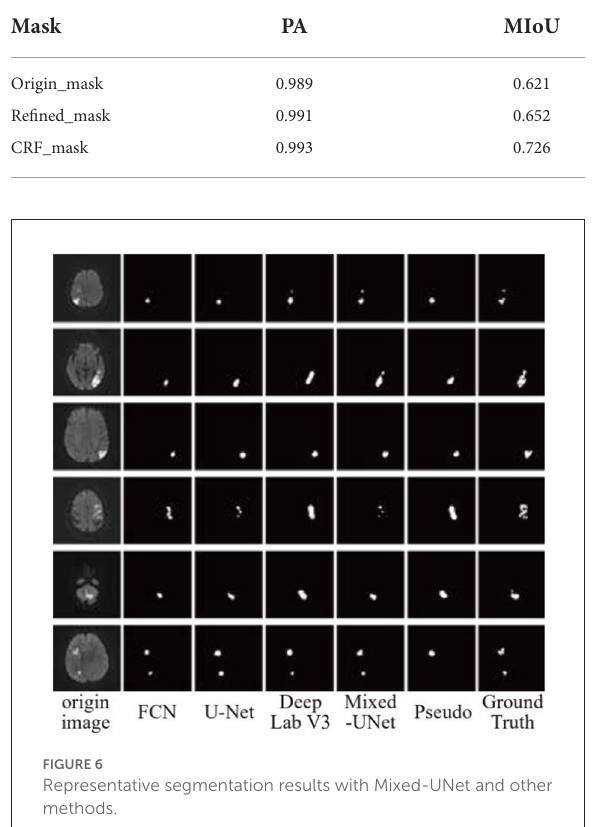
TABLE 3 The quantitative comparison of different models.